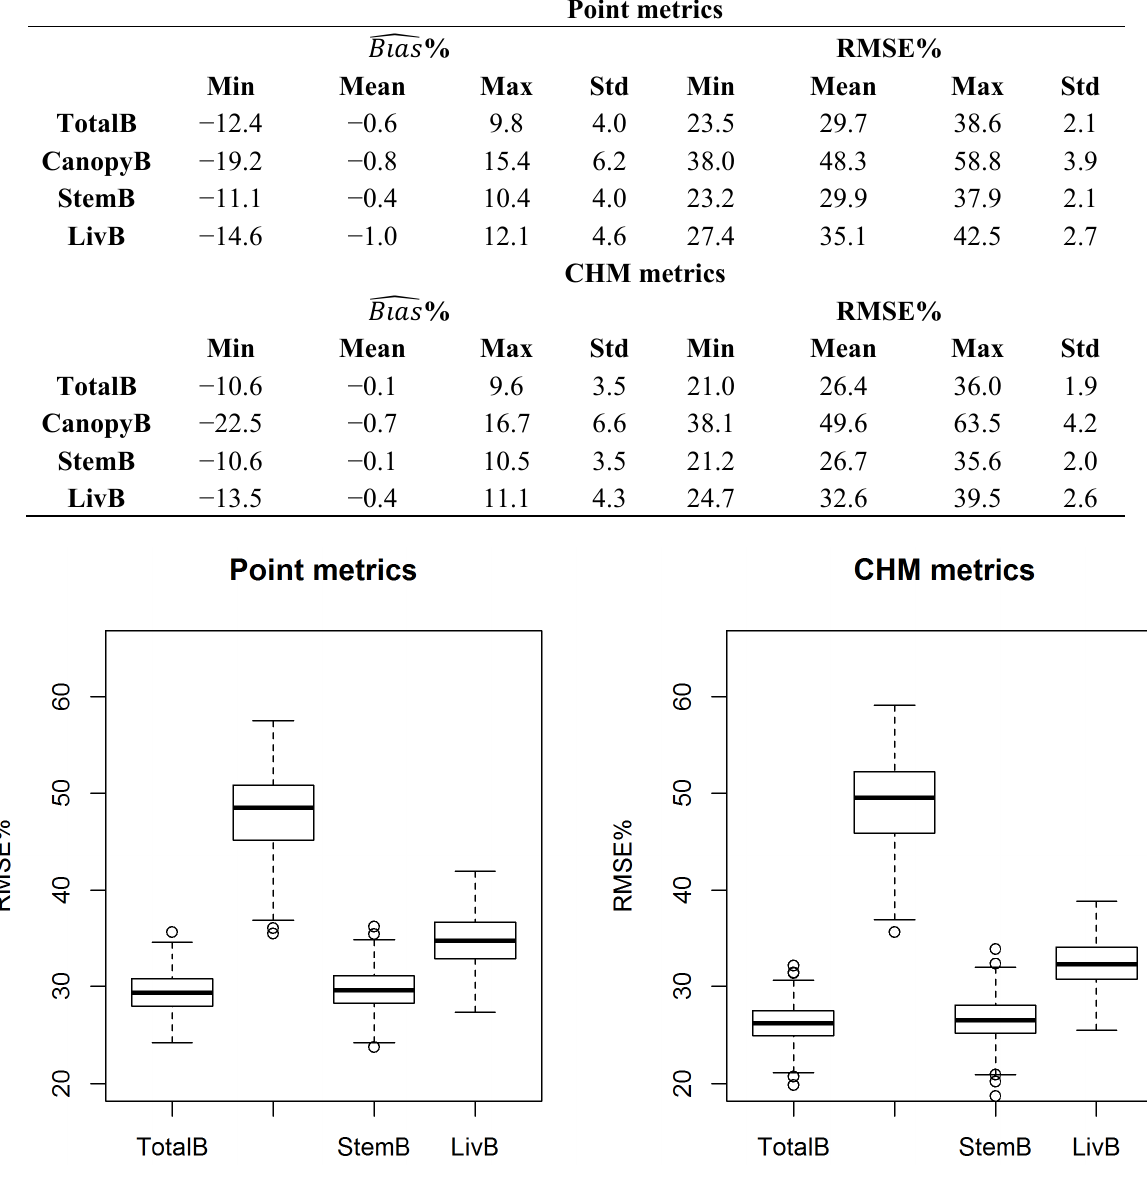
Figure 3. Boxplots of the variability of the RMSE% in the AGB predictions when repeating the NN predictions 500 times using ALS point metric or CHM-derived metrics as predictor